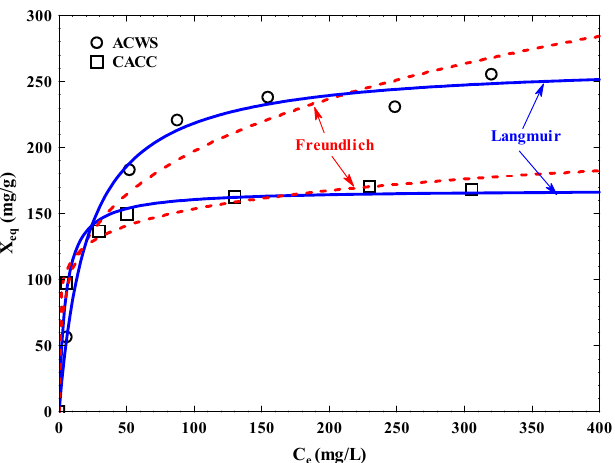
Figure 6. Adsorption isotherm of DPA onto ACWS ( ○ ) and CACC ( □ ) at T = 25 °C, pH ≈ 5 and carbon mass 100 mg. Table 6. Parameters calculated by applying the Langmuir and Freundlich isotherm models of DPA adsorption isotherms onto ACWS and CACC.